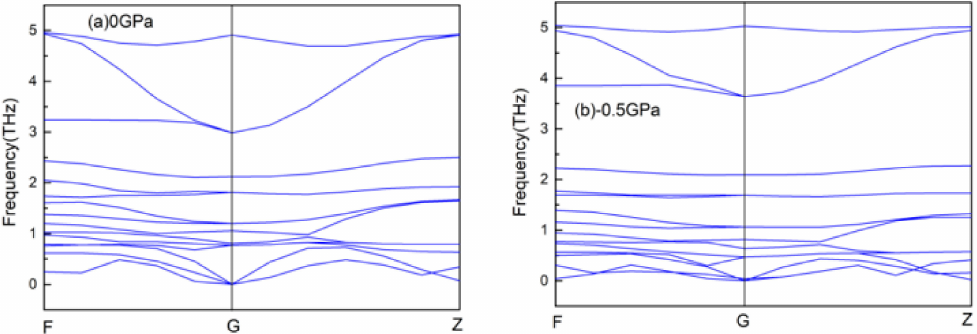
Figure 11. Phonon spectrum of CsGeI 3 under the pressure of ( a ) 0 GPa and ( b ) − 0.5